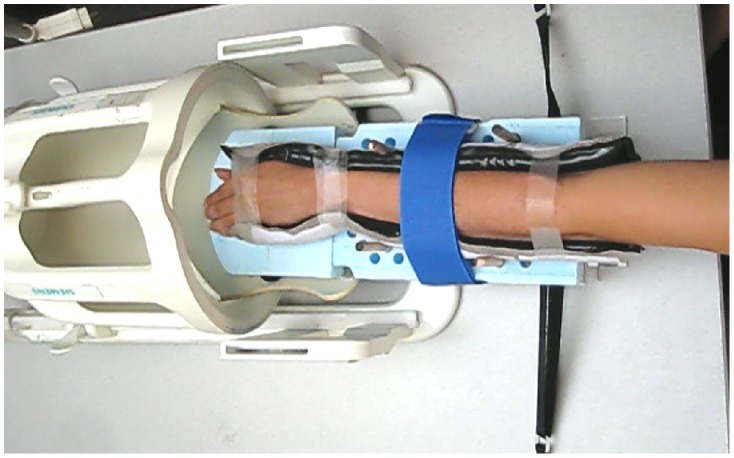
The forearm of a healthy volunteer in the wrist harness.The harness has been slid outwards for better visualization of both the harness and the MR coil.